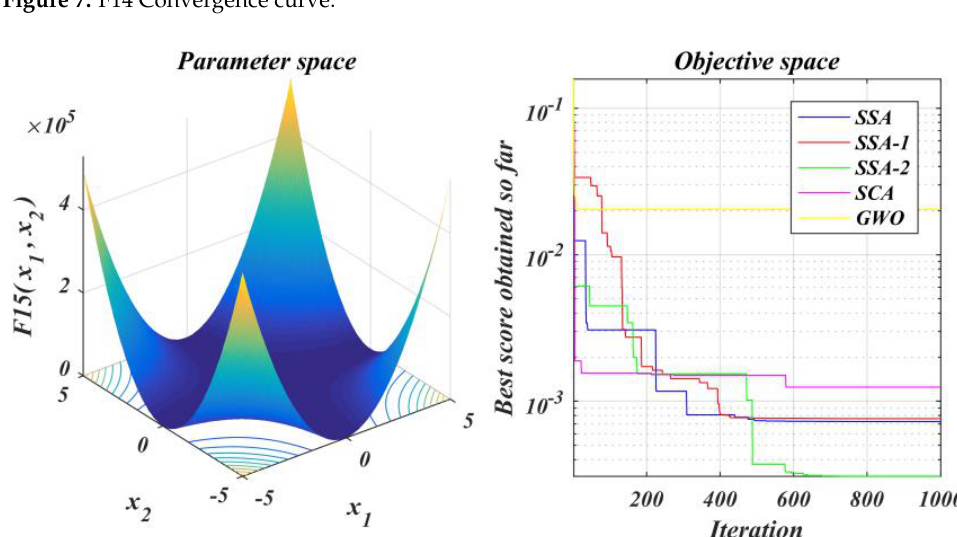
Figure 7. F14 Convergence curve.